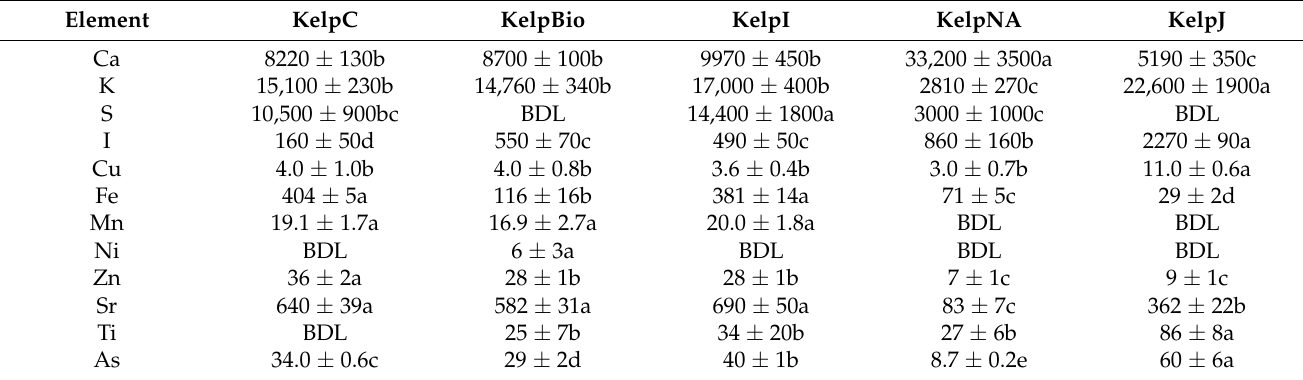
Table 1. Elemental composition of Kelp from different